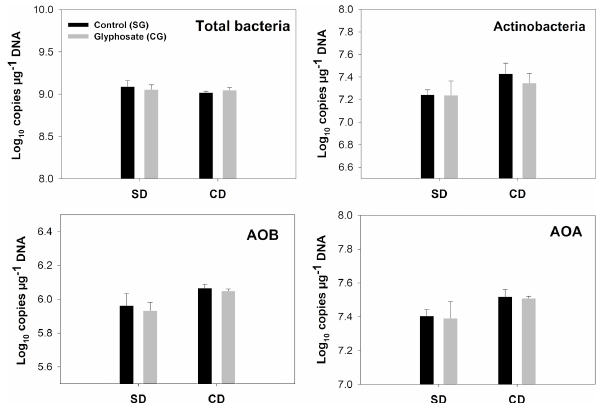
Figure 2. Copy number of indicator genes for total bacteria, Acti- nobacteria , AOB and AOA. Error bars indicate the standard error of the mean ( n = 3). SD/SG: no dry–rewetting disturbance/no herbi- cide; SD/CG: no dry–rewetting disturbance/herbicide; CD/SG: dry– rewetting disturbance/no herbicide; CD/CG: dry–rewetting distur-